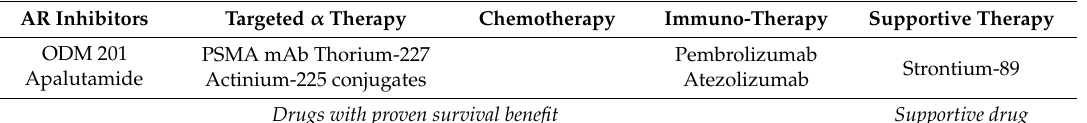
Table 3. Main drugs with studies currently ongoing on metastatic prostate